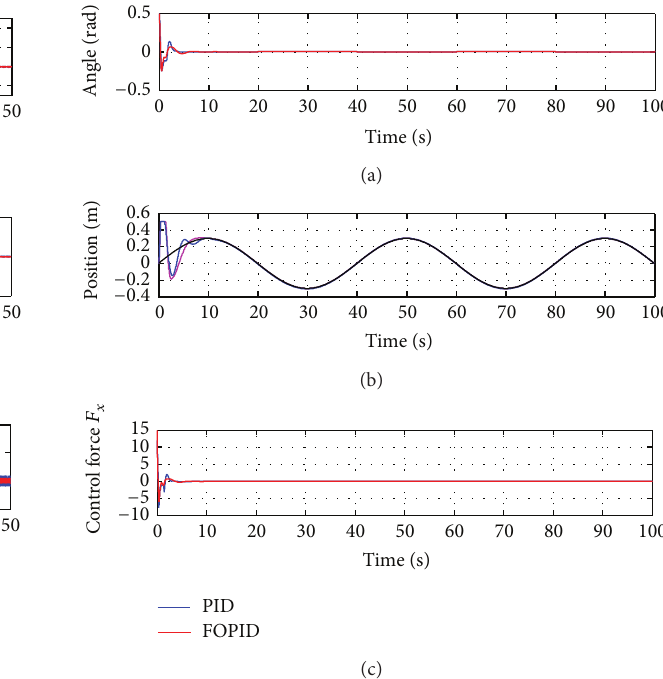
Figure 8: Tracking of inverted pendulum (without disturbances = 𝑑 = 0 ). 𝑑 1 2